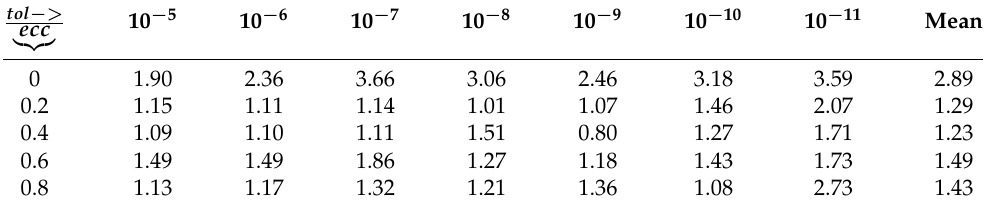
Table 3. Efficiency measure ratios of DLMP6(5) vs. NEW6(5) for Kepler in [ 0,10 π ] .